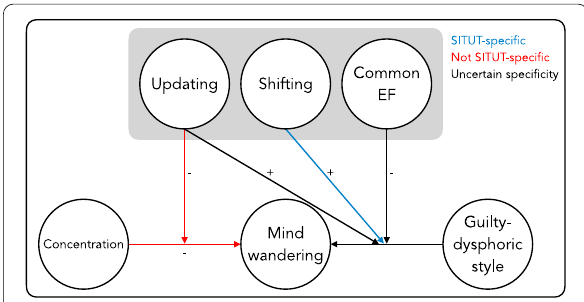
Fig. 5 Schematic conceptual depiction of the factors contributing to mind wandering based on the current results. The pluses indicate positive slopes and the minuses indicate negative slopes. For instance, the arrow from concentration to mind wandering indicates that trying harder to concentrate on current activity is associated with a decrease in mind wandering, whereas the arrow from updating pointing at the arrow from concentration to mind wandering indicates that individuals with higher updating show a more strongly negative slope of concentration on mind wandering (i.e., a moderation). The blue arrow indicates that the relation was observed specifically for stimulus‑independent and task‑unrelated thoughts (SITUTs), whereas the red arrows indicate that the relations were observed for multiple operationalizations of mind wandering, such as external distractions. EF executive =